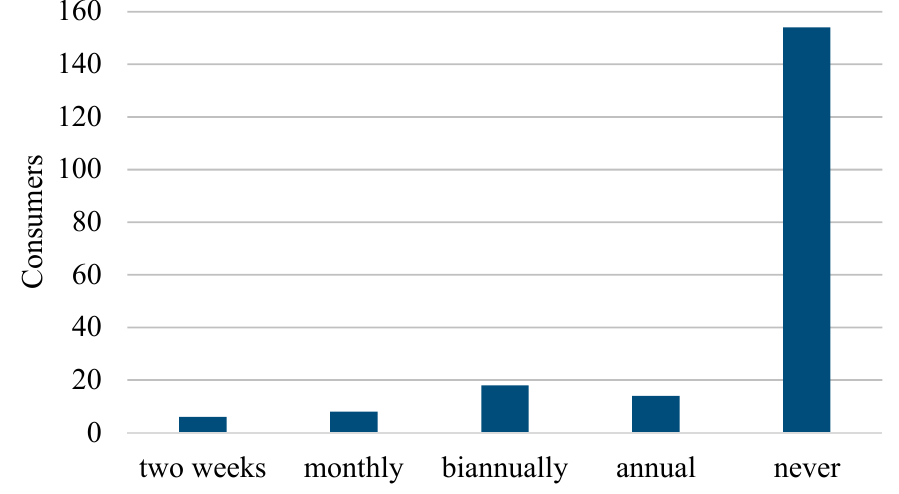
Figure 11. External cleaning of the refrigerator (condenser).